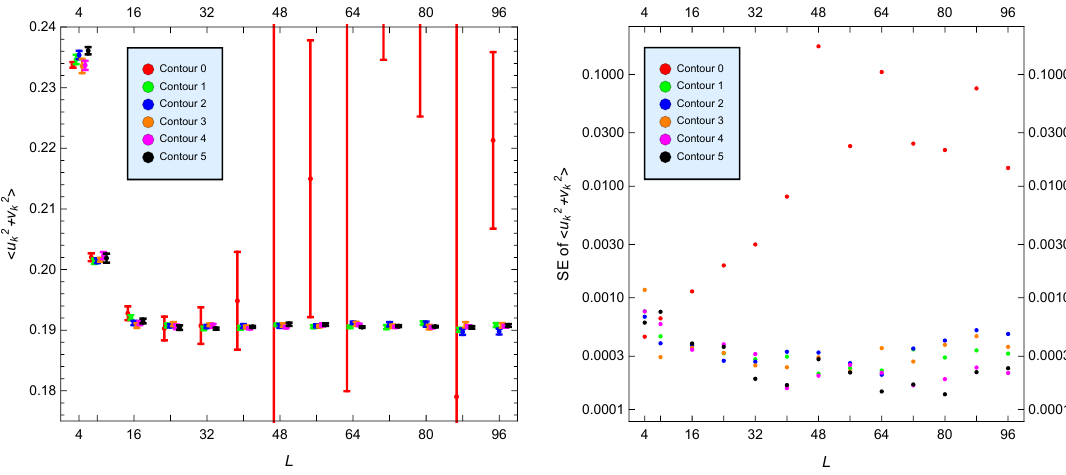
(cid:10) (cid:11) u 2 + v 2 as a function of lattice size. Di(cid:11)erent contours are separated horizontally k k